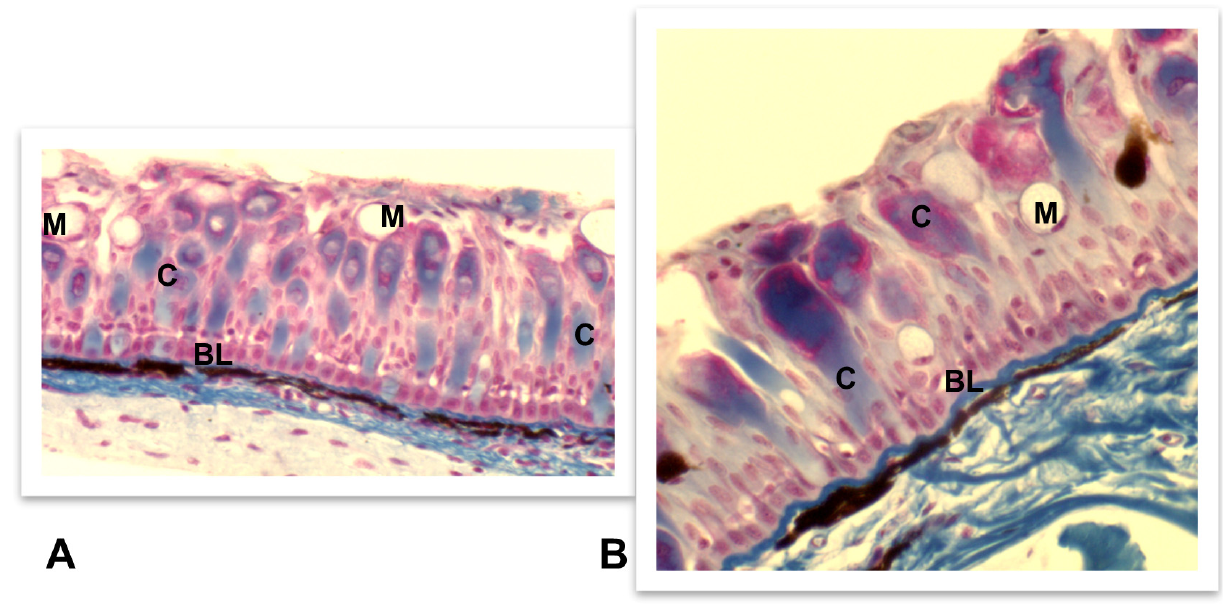
Figure 1. Light micrographs of the skin of Anguilla anguilla . Mallory staining. ( A ) Control and ( B ) exposed specimen. Cocaine exposure ( B ) caused the thickening and folding of the basal lamina (BL), the loss of apical vacuoles in club cells (C) and the decrease of mucous cells (M). Magnification: 400×. The intestinal epithelium, that at silver stage was degenerating, appeared thickened and convoluted, with many mucous cells. Also, the muscular layers were well organized, with fibers increased in size (Figure 2), that, however, began to regress ten days after the end of exposure to cocaine, when instead the epithelium still appeared well organized.